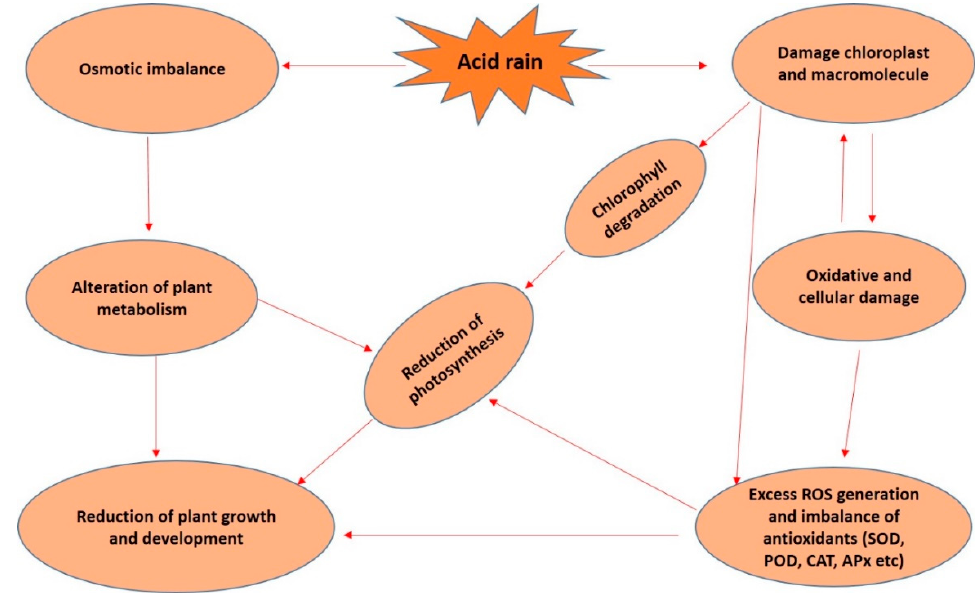
Figure 2. The action of acid rain stress on photosynthesis, antioxidant system and growth in plants. Here, ROS—reactive oxygen species, SOD—superoxide dismutase, POD—peroxide, CAT—catalase, APx—ascorbate